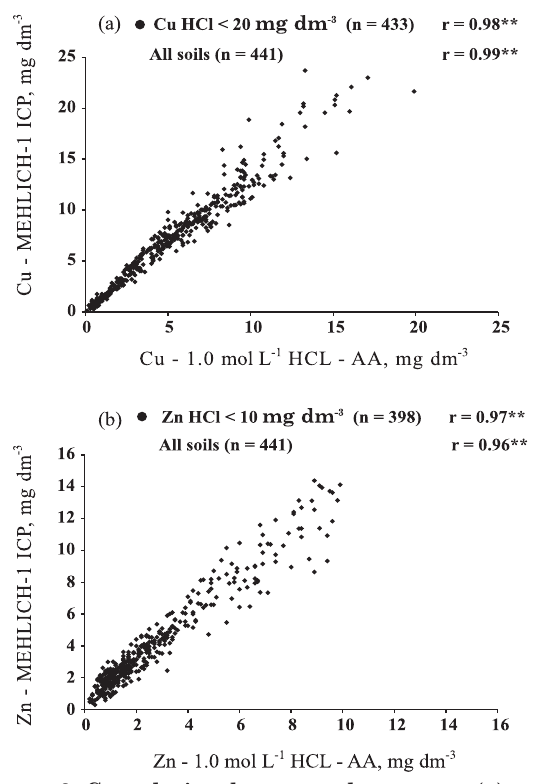
Figure 3. Correlation between the copper (a) and zinc (b) amounts extracted by the 0.1 mol L -1 HCl solution determined by the atomic absorption spectrometry (AA) and the copper and zinc amounts extracted by the Mehlich-1 solution determined by the ICP method